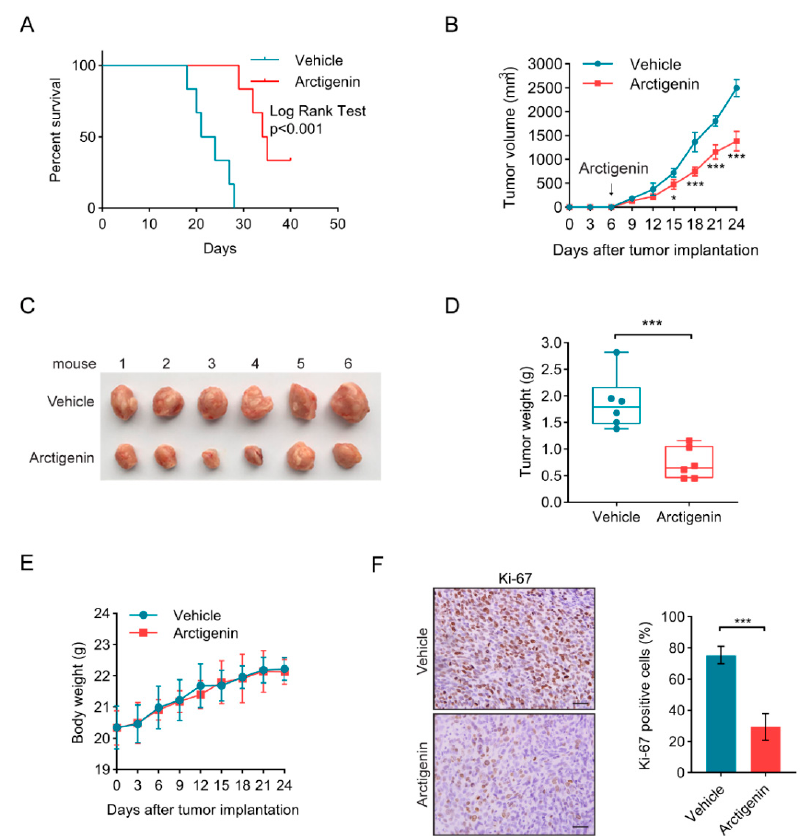
Figure 1. Arctigenin attenuates breast cancer growth in vivo. ( A ) Kaplan–Meier plot of survival of 4T1 tumor-bearing mice treated with vehicle or arctigenin. n = 6 mice / group, p < 0.001 (Log Rank test). ( B ) The growth curve of 4T1 tumors in mice treated with arctigenin or vehicle. Arrows indicated the start day of arctigenin administration. ( C ) Photograph of the tumors separated from mice in each group. ( D ) The tumor weight of 4T1 tumors treated with arctigenin or vehicle. ( E ) The body weight of mice treated with arctigenin or vehicle. ( F ) Representative Ki-67 staining (left panel) and statistics (right panel) of the 4T1 tumor sections. Scale bar, 100 µ m. For ( B , D , E ), data represent mean ± SD from six mice. Statistically significant differences are indicated: * p < 0.05, *** p < 0.001 (Student’s t test). 2.2. Arctigenin Suppresses GM-CSF and TSLP Expression in Breast Cancer Cells